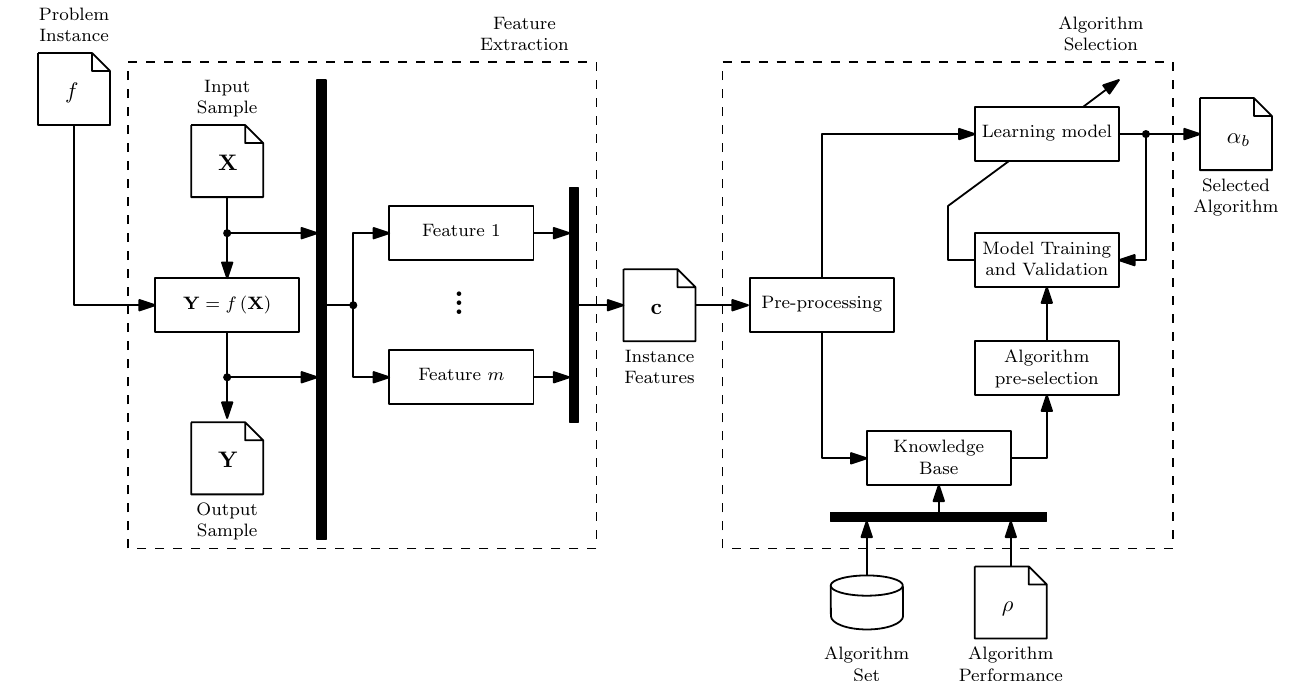
Figure 2. Details of the feature extraction and algorithm selection